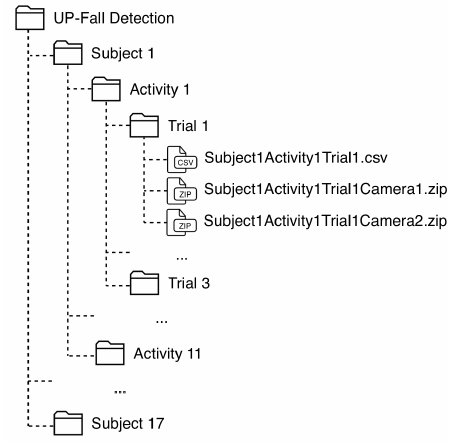
Figure 3. Organization of the consolidated